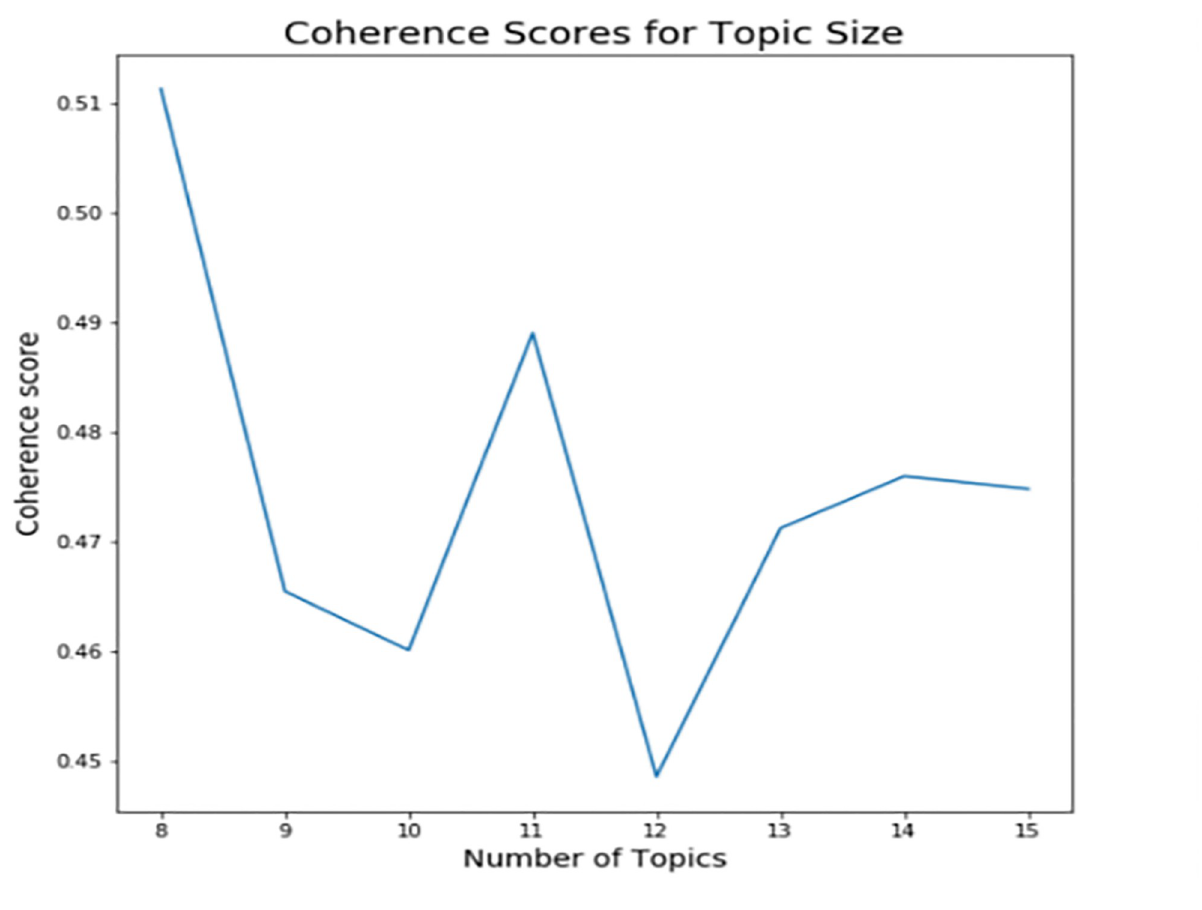
Fig 2. Coherence score for UK job posting